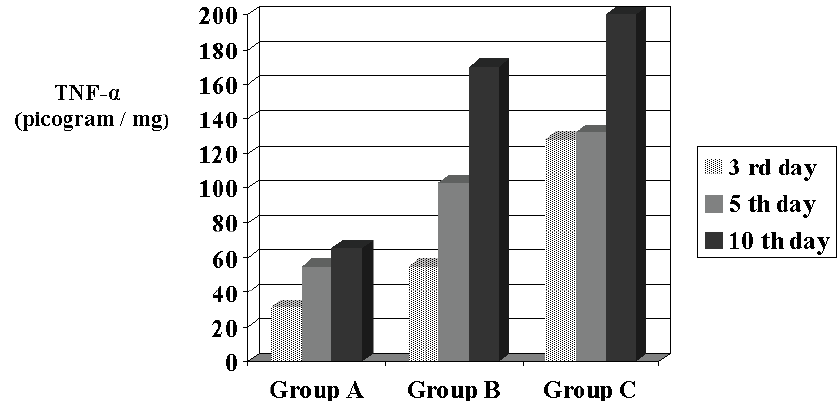
Figure 1. Levels of TNF- α on the 3 rd , 5 th and 10 th days in Group A, B and C. A significant difference on the 3 rd and 10 th days was observed between Group B and C (p<0.05).